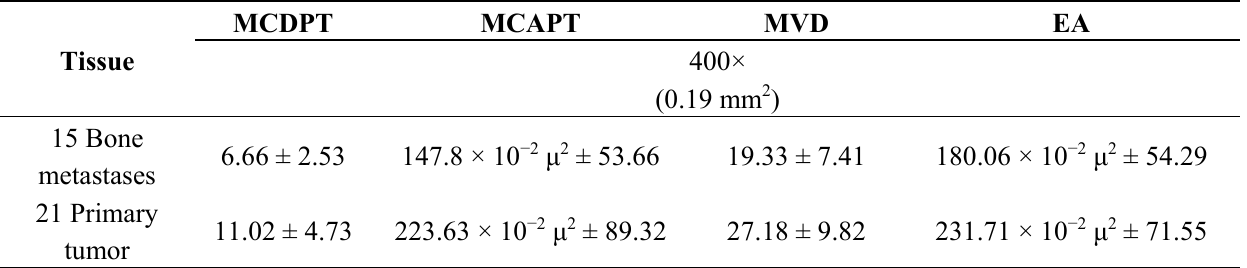
Figure 1. Bone metastasis from gastric cancer tissue section. Large arrows indicate red immunostained mast cells near microvessels. Single small arrow indicates the lumen of a microvessel with a single red blood cell in its lumen as an internal positive control. Double small arrow indicates a small microvessel with red blood cells in its lumen as an internal positive control. Discontinuous small arrow indicates a developing microvessel with a red immunostained endothelial cell positive to tryptase induced by the adjacent red immunostained mast cell positive to tryptase. The asterisk indicated a cluster of blue nuclei of gastric cancer cells. Maximum magnification of light microscopy 1000× in oil. Mean values ± 1 standard deviations (SD) of all the tissue-evaluated parameters are reported in Table 1. With special reference to BMGCP, there was a significant correlation between MCDPT and MVD ( r = 0.82, p = 0.00), between MCDPT and MCAPT ( r = 0,77, p = 0.01), between MCDPT and EA ( r = 0.73, p = 0.01), between MCAPT and MVD ( r = 0.68, p = 0.02), between MCAPT and EA ( r = 0.71, p = 0.02), and between MVD and EA ( r = 0.78, p = 0.01) (Figure 2). G3 grading significantly correlated with bone metastasis ( p = 0.001). No correlation concerning MCDPT, MCAPT, MVD, EA and the other main clinicopathological features was found. Table 1. Mast cells (MCs) density positive to tryptase (MCDPT), MCs area positive to tryptase (MCAPT), microvascular density (MVD) and endothelial area (EA) means ± standard deviations as a function of bone metastases from gastric cancer patients (BMGCP) and primary tumor tissue